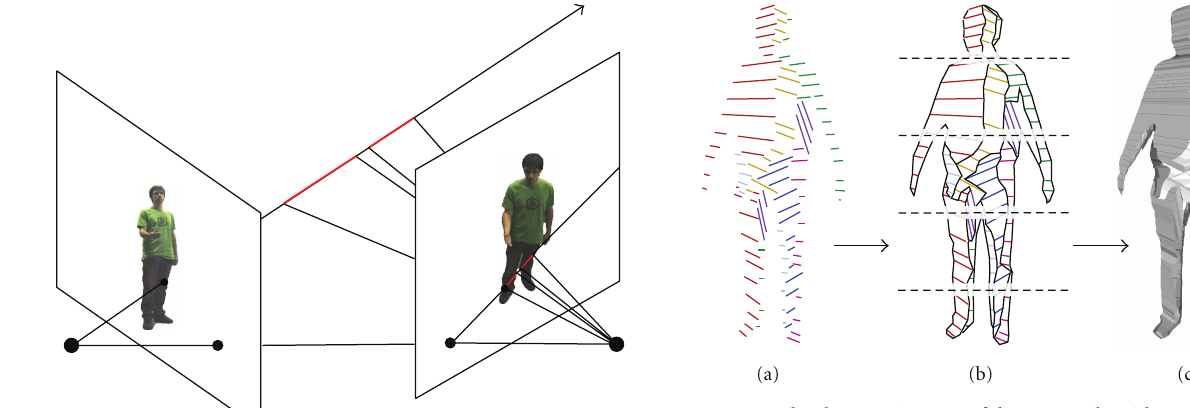
Figure 5: The three main steps of the EPVH algorithm, (a) viewing edge computation, (b) mesh connectivity (horizontal slices depict the partitioning used for the parallel version of the algorithm), and (c) face